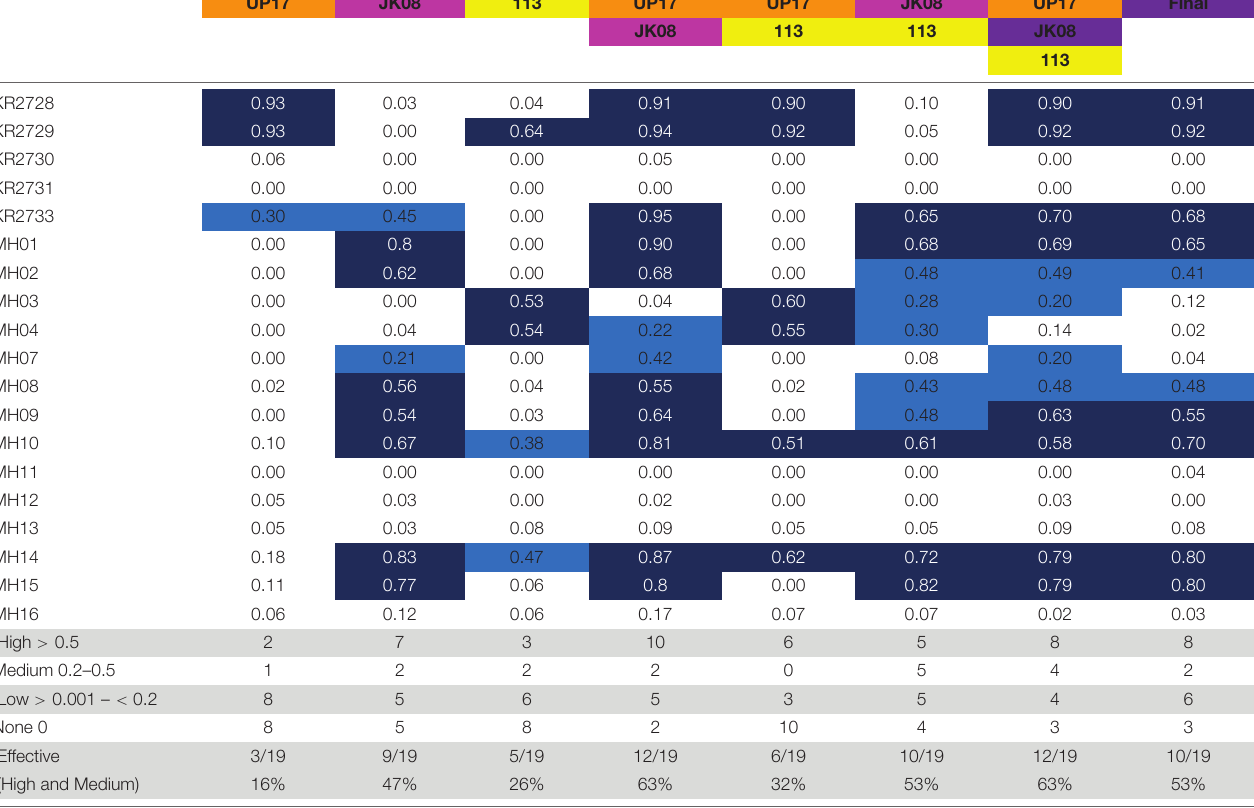
TABLE 1 | The virulence index scores of individual phage and various phage combinations across all the 19 ESBL-producing E. coli clinical isolates.